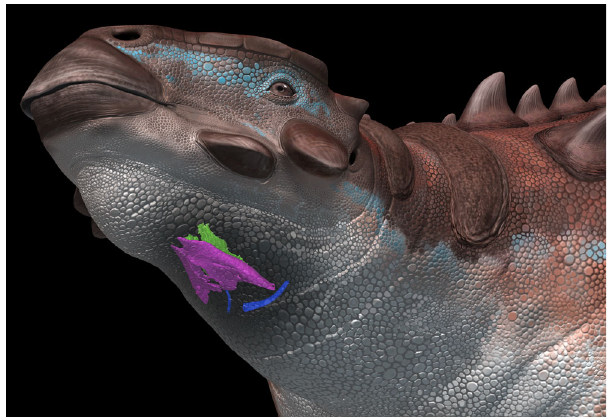
Fig. 3 Hyolaryngeal apparatus of Pinacosaurus in a life restoration. Cricoid (purple), arytenoid (green), and ceratobranchial (blue) are depicted. Artwork by Tatsuya